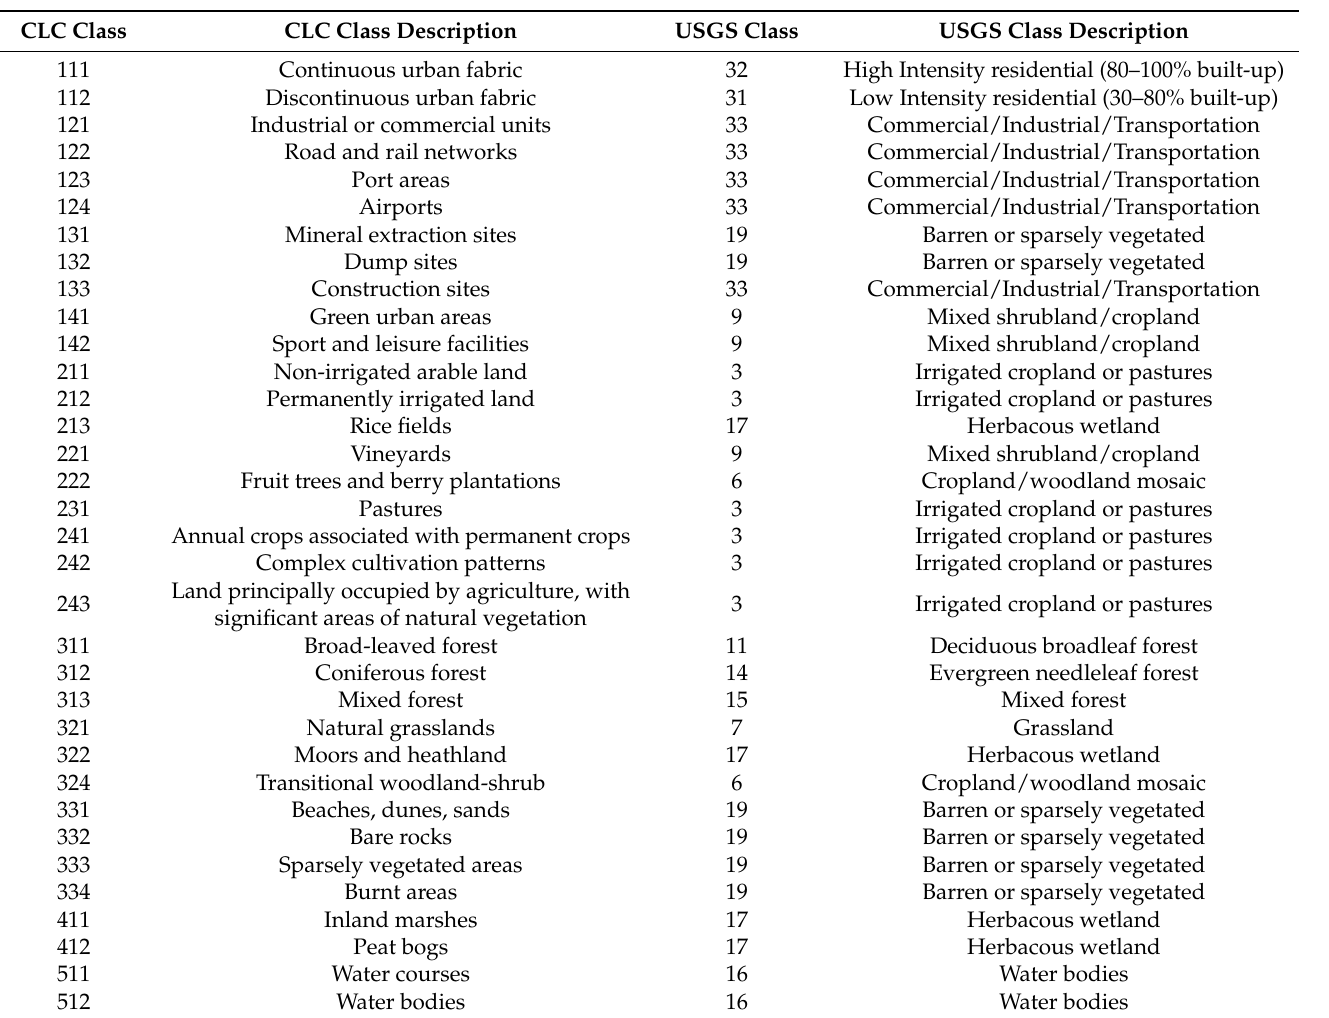
Table A2. Reclassification of Corine Land Cover 2018 (CLC) classes to United States Geological Survey (USGS)